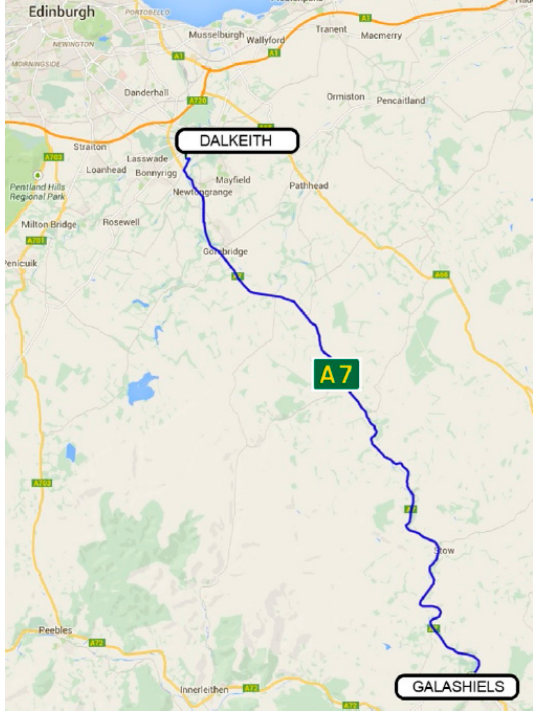
Figure 2. Experimental commute route (Google Maps, 2018).